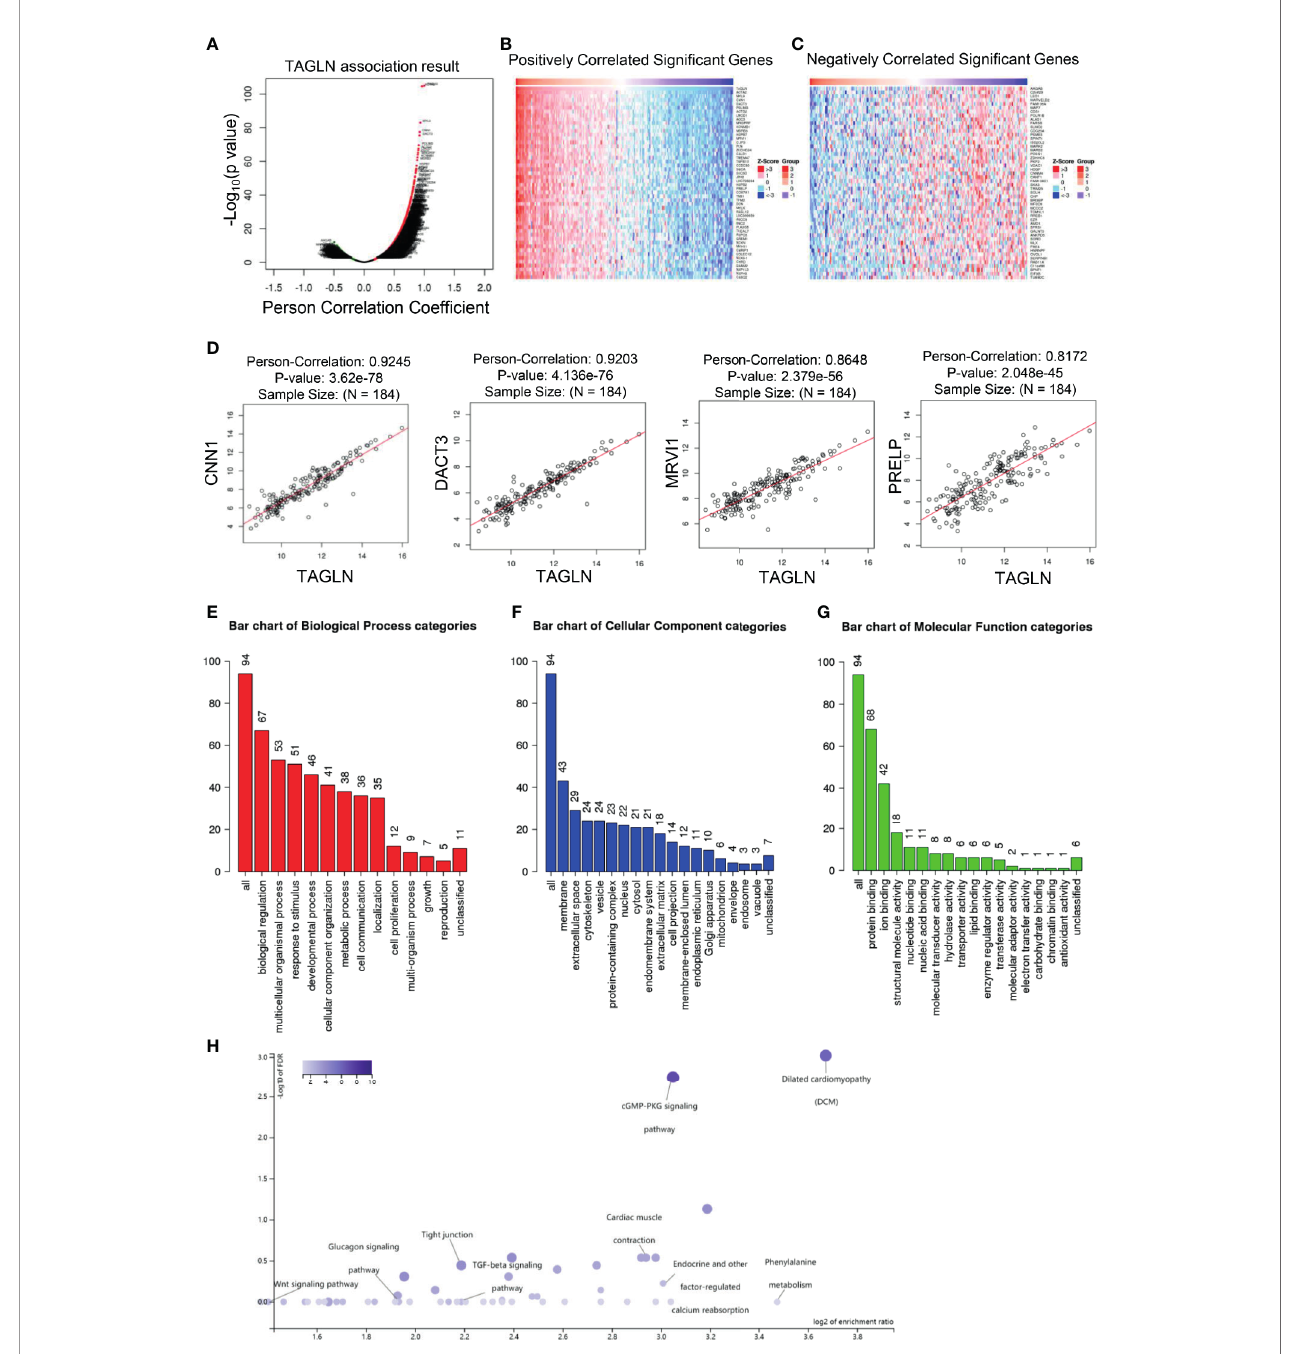
FIGURE 7 | Transgelin co-expressed genes and GO and KEGG enrichment analysis. (A) Volcano map analysis results of Transgelin co-expressed genes. (B) Heat map analysis of co-expressed genes positively correlated with Transgelin in esophageal squamous cell carcinomas. The red color is the positive gene and the green color is the negative gene. (C) Heat map analysis of negatively correlated genes co-expressed with Transgelin in esophageal squamous cell carcinomas. The red color is the positive gene and the green color is the negative gene. (D) Correlation analysis of Transgelin, CNN1, DACT3, MRVI1, and PRELP gene expression. The scatter plot showed Pearson correlation between Transgelin expression and other gene expression. (E) Results of biological process enrichment analysis of Transgelin co-expressed genes. (F) Results of cellular component enrichment analysis of Transgelin co-expressed genes. (G) Results of molecular function enrichment analysis of Transgelin co- expressed genes. (H) KEGG enrichment analysis results of Transgelin co-expressed